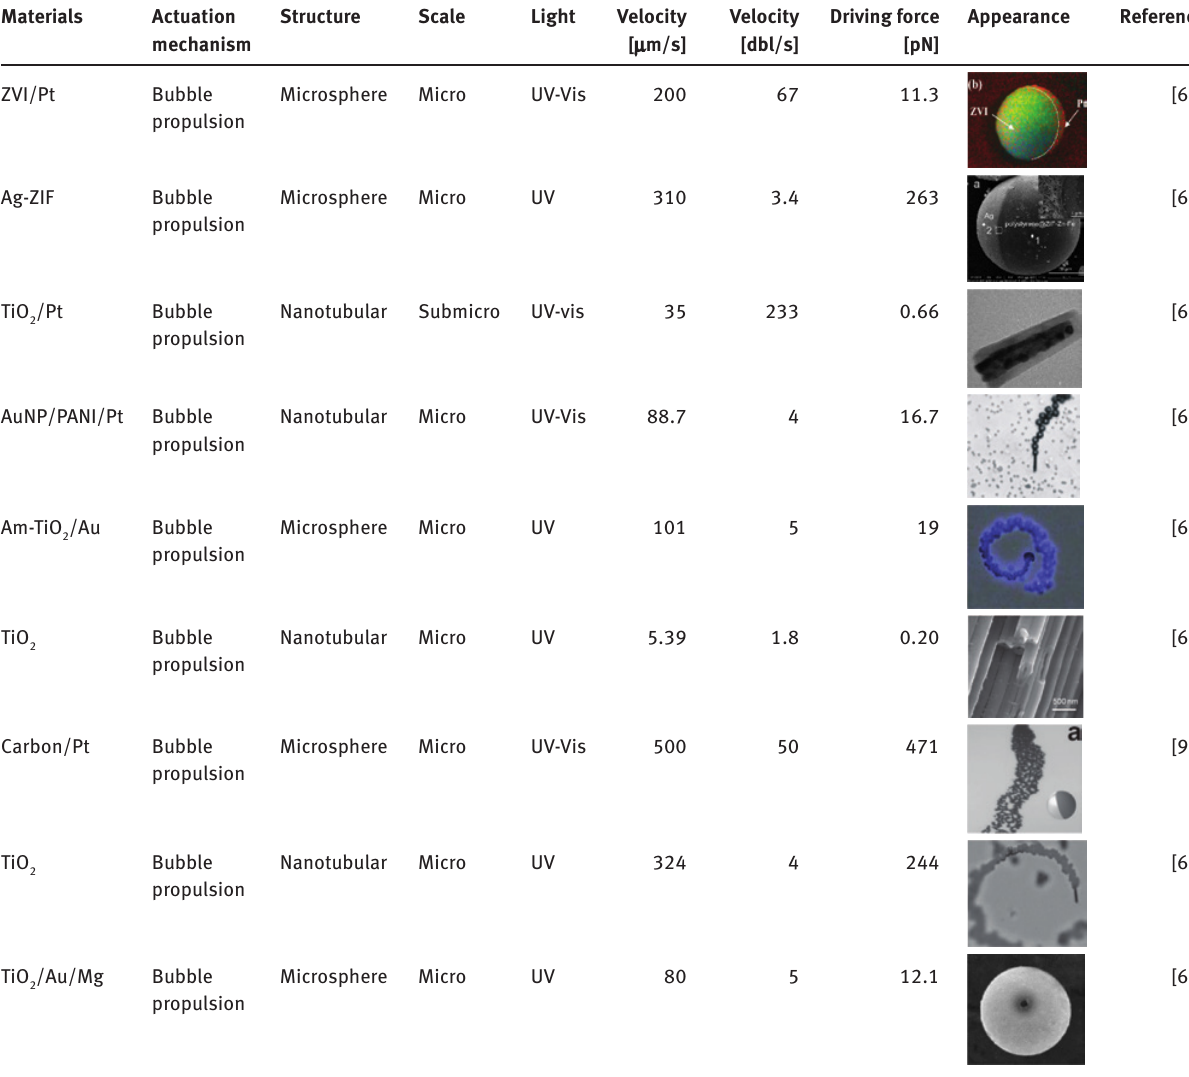
Table 2: Comparison of motion velocity and estimated driving force for light-driven micro/nanomotors through bubble propulsion.